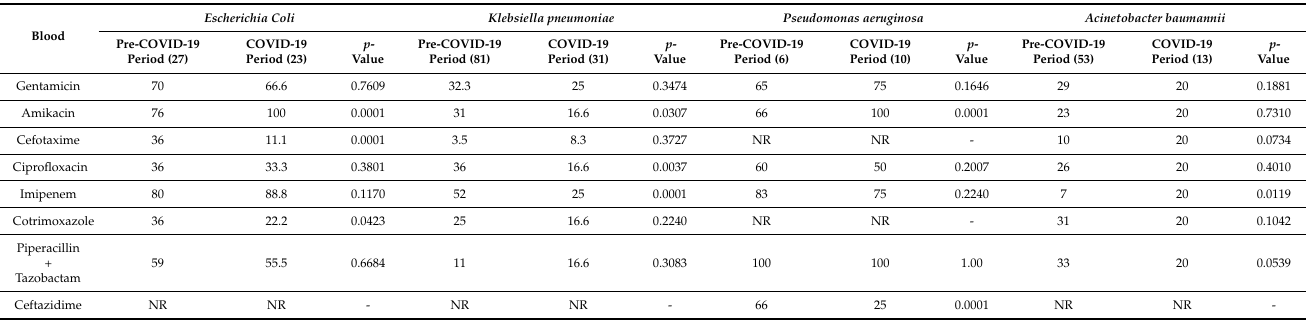
Table 3. Comparison of antimicrobial susceptibility pattern of Gram negative bacteria in blood samples between pre-COVID and COVID period.